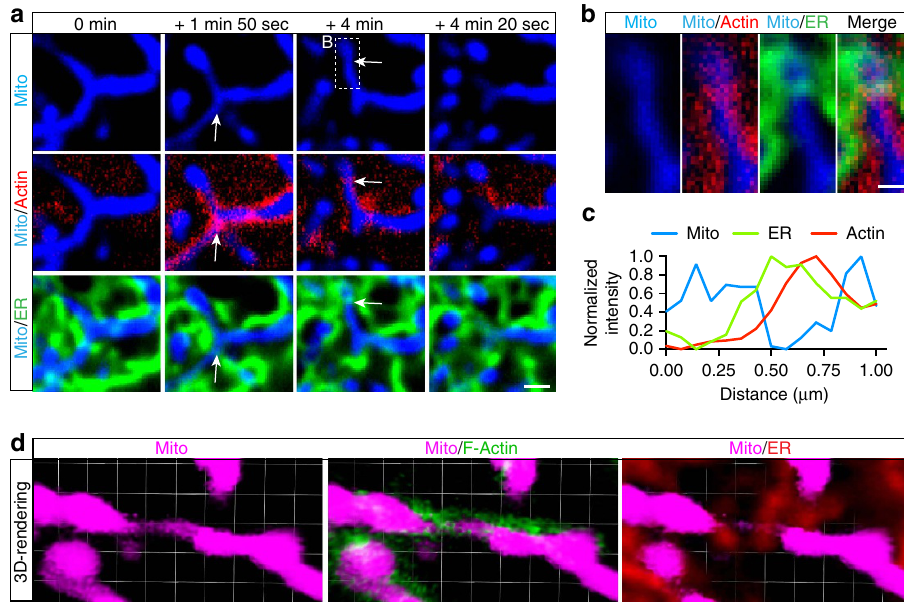
Figure 7 | Actin assembles at ER–mitochondria contact sites. ( a ) Confocal image of GFP-actin (red) recruitment to elongated, Mito-SNAP-labelled mitochondria (blue) in a HeLa cell. Actin assembly is enriched at sites of ER tubule (DsRed2-ER, green) overlap with mitochondria. Arrows indicate regions of Actin/ER co-localization at prospective sites of mitochondrial fission. ( b ) Enlarged image of Box B ( þ 4min), demonstrating co-localization of actin and ER at the site of mitochondrial fission. ( c ) Line scan indicating overlapping peak actin and ER intensity at site of mitochondrial constriction in ( b ). ( d ) Three-dimensional rendering of F-actin (LifeAct-GFP) and ER-tubules (DsRed2-ER) assembled on a constricted HeLa cell mitochondrion (Mito-SNAP). Scale bars, 1 m m ( a ), 0.5 m m ( b ) and 0.75 m m per unit ( d ).